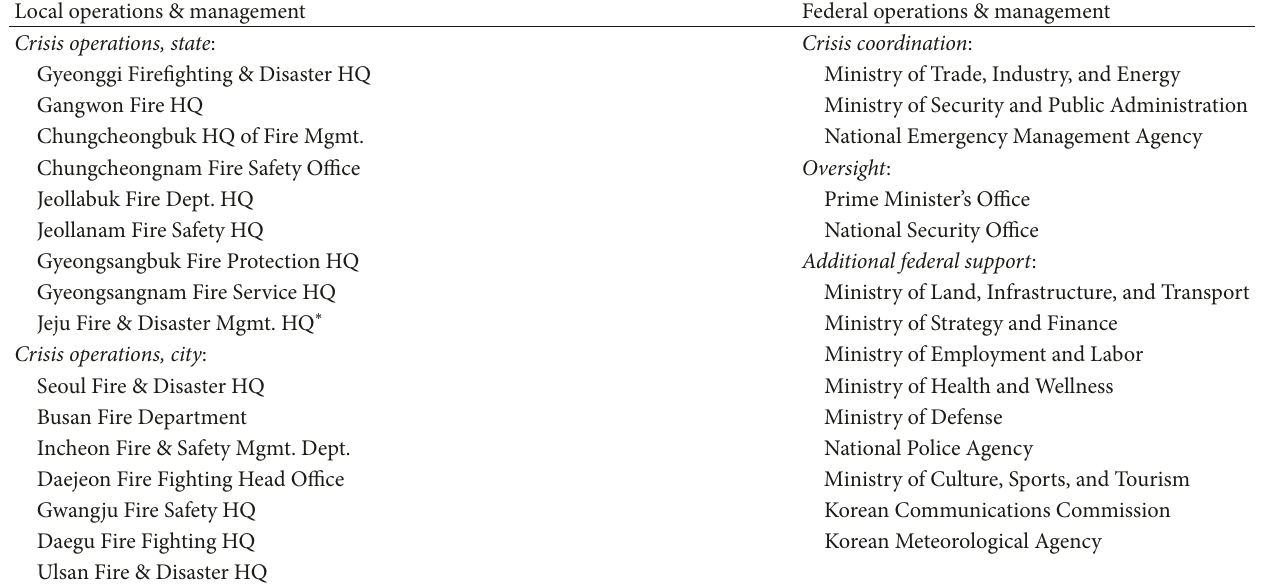
Table 2: Disaster management industry